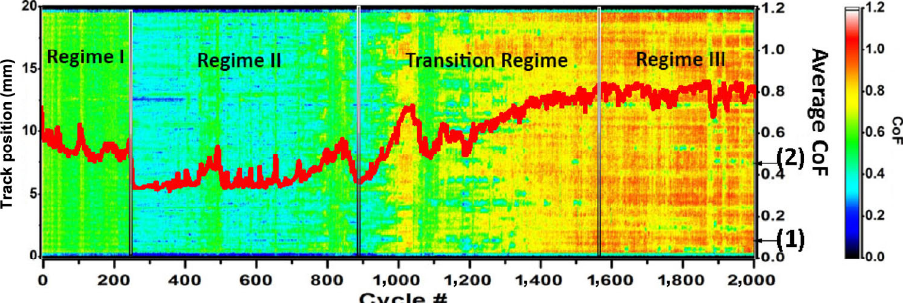
Fig. 12 Triboscopic image superimposed with average CoF at